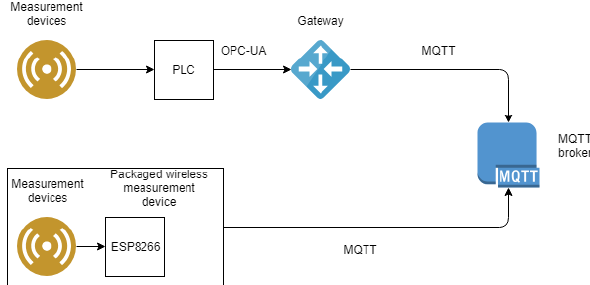
Figure 4: Distribution of clusters based on month. March contains